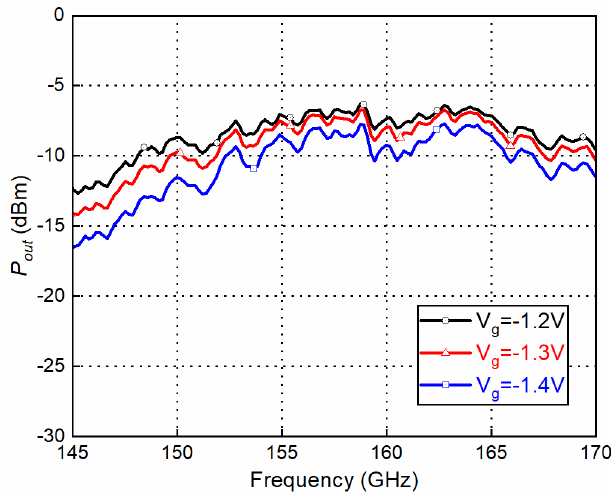
Figure 16. Output power vs. frequency (IF @ 10 dBm and LO @ 13 dBm).